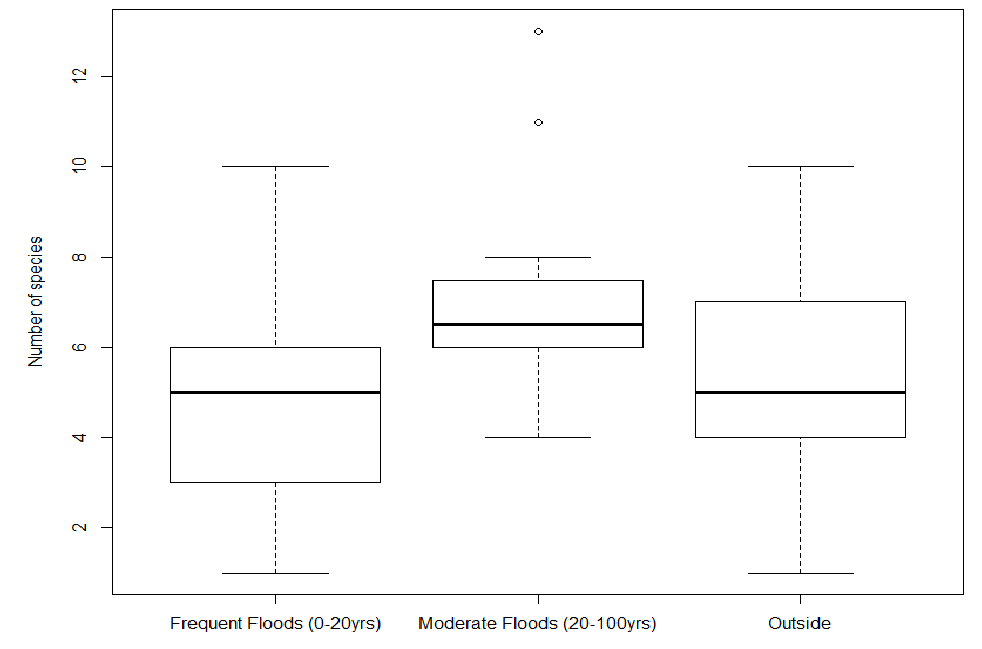
Figure 5. Graph of species richness following the three different zones (Flood recurrence interval of 0–20 years; Flood recurrence interval of 20–100 years; Outside the